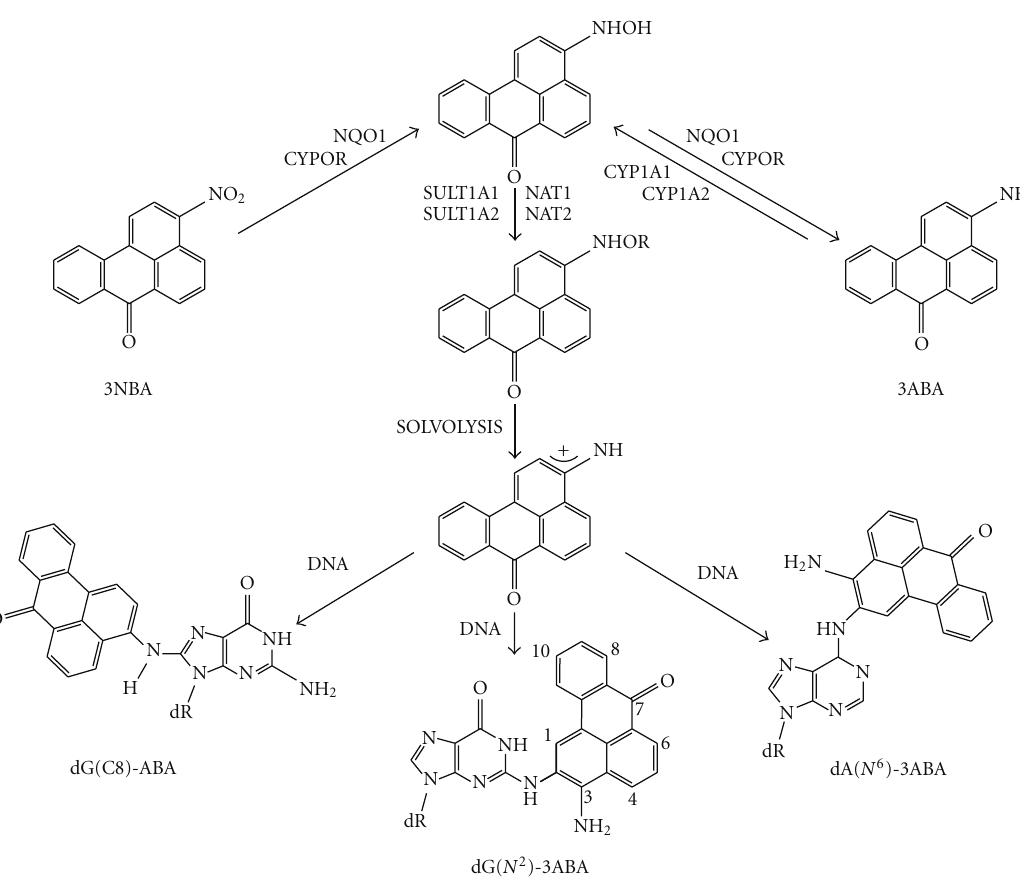
Figure 1: Metabolic activation of 3-nitrobenzanthrone and DNA adduct formation. NQO1, NAD(P)H:quinone oxidoreductase; CYPOR, NADPH:cytochrome P450 (P450) reductase; CYP1A1/2, cytochrome P450 1A1/2; NAT1A1/2, N,O acetyltranferases; SULT1A1/2, sulfotransferase 1A1/2; dG(C8)-ABA, N -(2 (cid:2) -deoxyguanosin-8-yl)-3-aminobenzanthrone; dG( N 2 )-3ABA, 2-(2 (cid:2) -deoxyguanosin- N 2 -yl)-3- aminobenzanthrone; dA( N 6 )-3ABA, 2-(2 (cid:2) -deoxyadenosin- N 6 -yl)-3-aminobenzanthrone. Numbering of the benzanthrone moiety is shown in the dG( N 2 )-3ABA